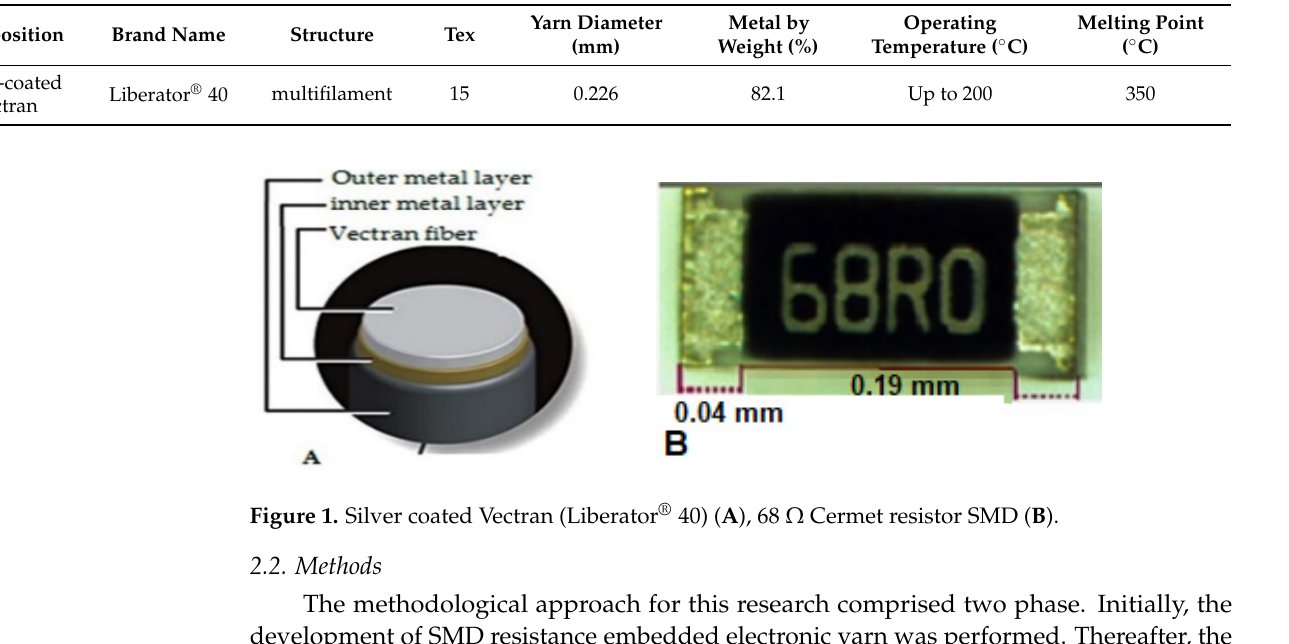
Table 1. Overview of Vectran (Liberator ® 40) conductive yarn.